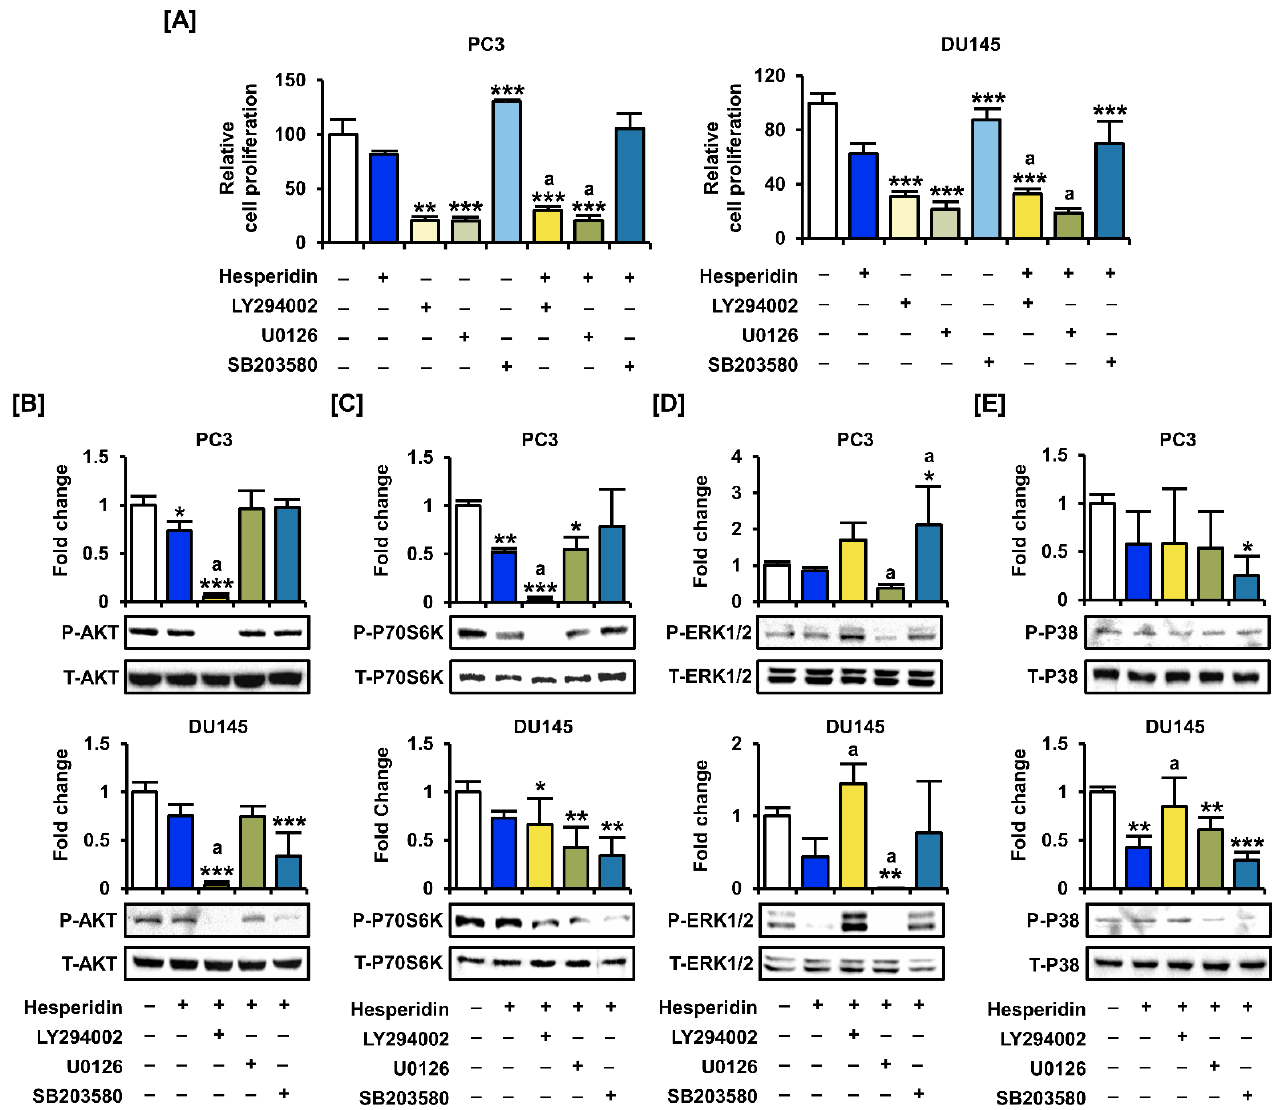
Figure 7. Effects of inhibitors of the PI3K and MAPK pathways on the proliferation of prostate can- cer cells treated with hesperidin. ( A ) Relative proliferation of PC3 and DU145 cells was verified after cotreatment with LY294002, U0126, or SB203580 and hesperidin for 48 h. ( B – E ) Phosphorylation of AKT ( B ), P70S6K ( C ), ERK1/2 ( D ), and P38 ( E ) proteins in PC3 and DU145 cells following cotreatment with LY294002, U0126, or SB203580 and hesperidin was analyzed via immunoblotting. All results of the arithmetic mean ( n = 3) denote statistical significance with asterisks (* p < 0.05, ** p < 0.01, and *** p < 0.001). The symbol ‘a’ indicates statistical significance (* p < 0.05) of the combination treatment compared to hesperidin treatment alone.